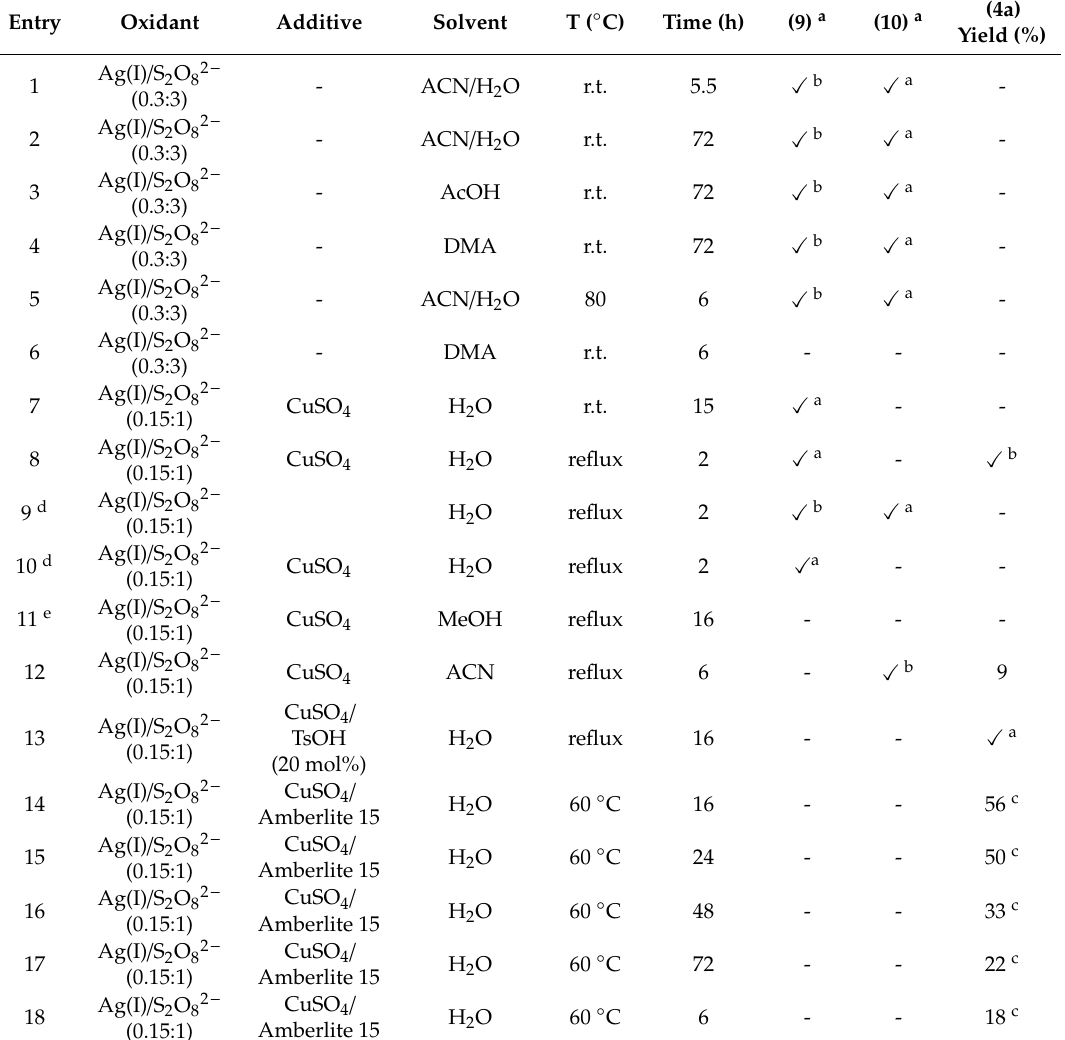
Table 4. Screening and results for the oxidative decarboxylation of carbamimidoyl- l -proline ( 2 ) and trapping the iminium intermediate with